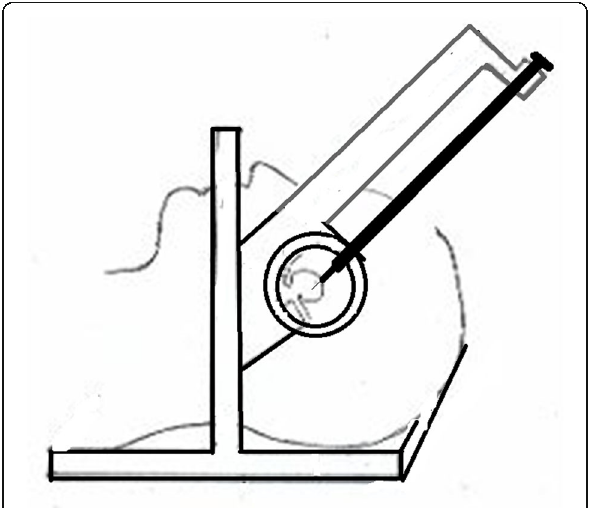
Fig. 4 Clinical set-up for stereotactic